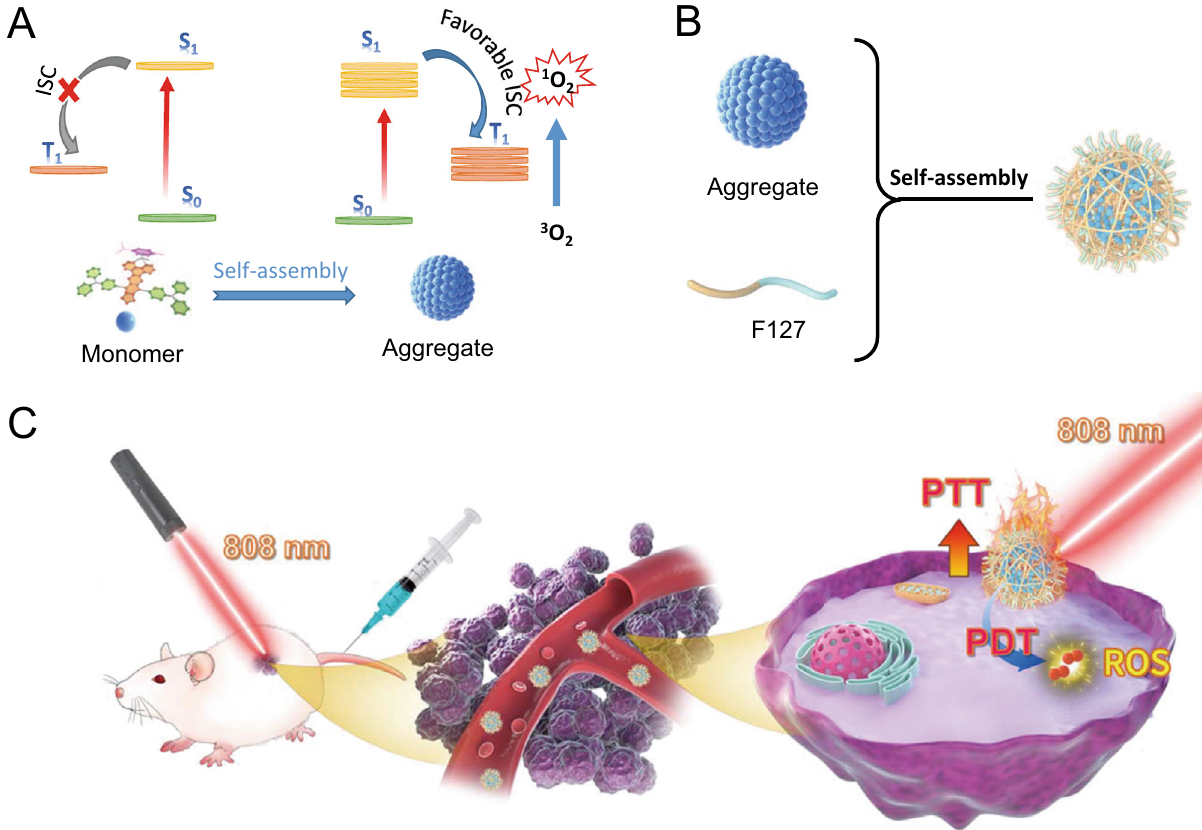
Fig. 1 Schematic illustration of RuDA-NPs for phototherapy. A Schematic illustration of the photophysical mechanism of RuDA in monomer and aggregate forms for cancer phototherapy, B synthesis of RuDA-NPs, and C RuDA-NPs for NIR-activated PDT and PTT.